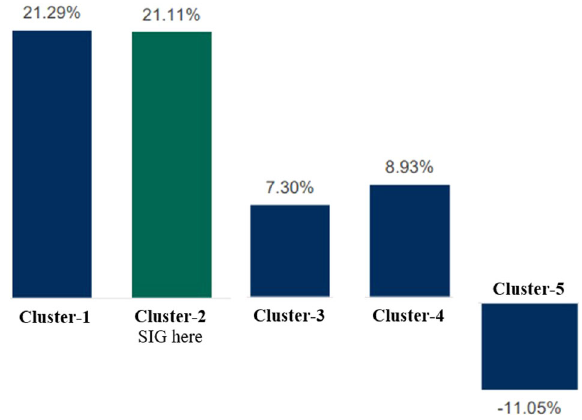
Fig. 5 Pool allocation of annual bonuses to EAT (2021). These fi ndings are based on exercise and evaluation and the higher clusters evidently distributed the higher bonus pool that allocated for